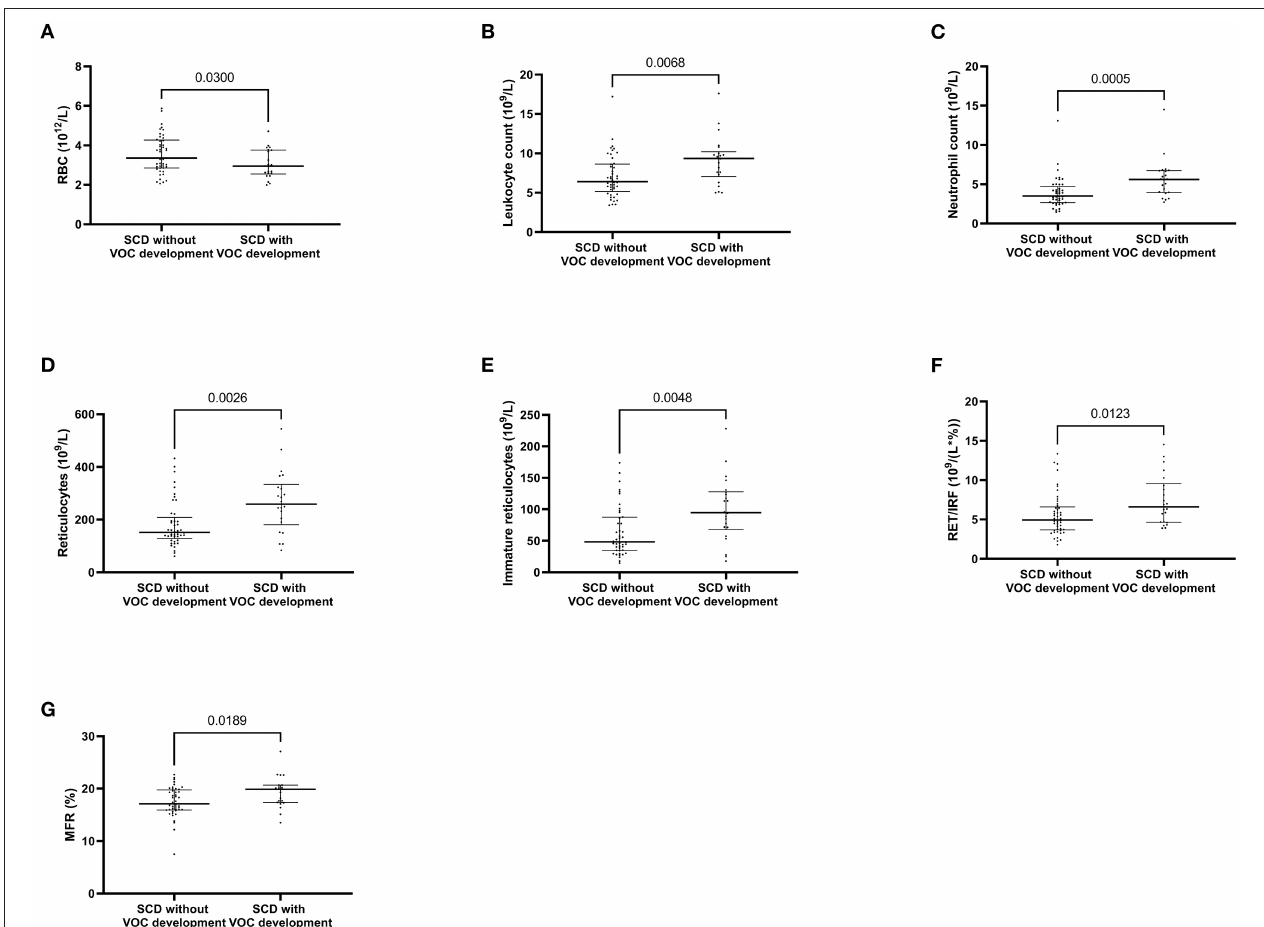
FIGURE 1 | Whole blood count and reticulocyte parameters associated with vaso-occlusive crisis development. Red blood cells (A) Leukocyte count (B) Neutrophil count (C) Reticulocytes (D) absolute value of immature reticulocytes (E) Part of immature reticulocyte fraction (F) medium fluorescent reticulocytes (G) . P values comparing clinical improvement to clinical worsening are from Mann-Whitney U -test.